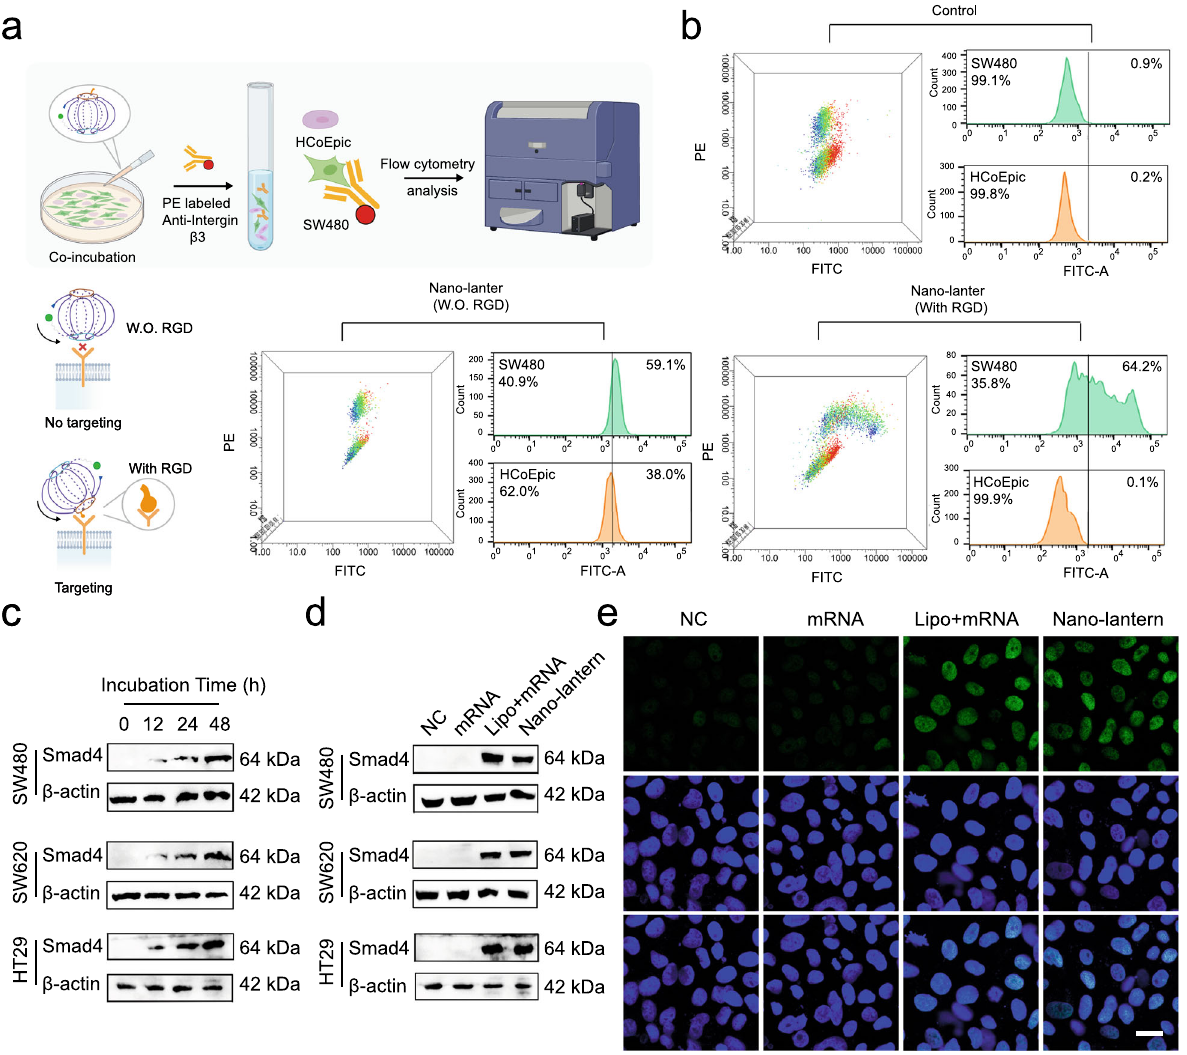
Fig. 5 | Target ability and intracellular Smad4 expression of nano-lantern in vitro. a Schematic illustration of targeting experiments by fl ow cytometry ana- lysis. Created with BioRender.com. b Characterization of the targeting ability of Smad4 mRNA nano-lantern with or without (W.O.) RGD modi fi cation by fl ow cytometryanalysis.ThegatingstrategywasprovidedintheSupplementaryFig.16c. c Representative western blot analysis of Smad4 protein expression in SW480 and SW620cellstreatedwithmRNAnano-lanternfordifferent incubationtimesfrom3